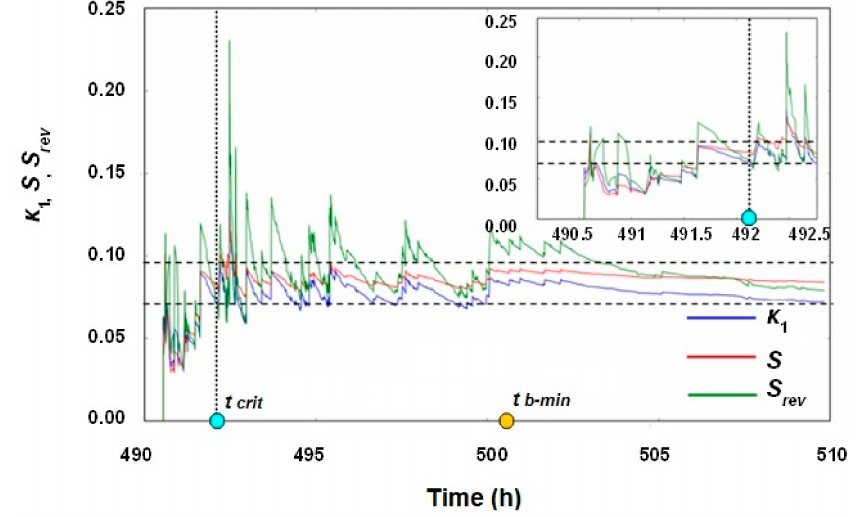
Figure 6. Time evolution of natural-time quantities κ 1 , S and S rev . Horizontal dashed lines represent the characteristics value κ 1 = 0.07 and S u = 0.0966 defining the criticality initiation time t crit . Note the relative positions of t crit and t b-min along the time-axis (the inset shows the approach of natural-time quantities to the critical